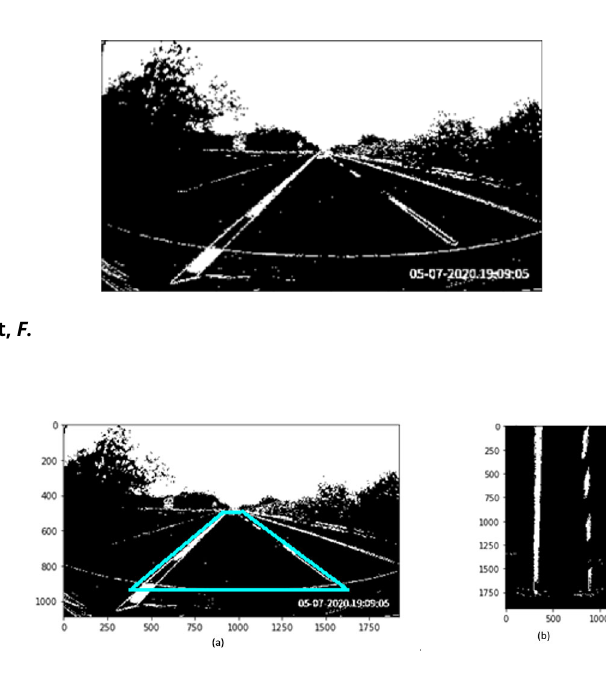
Figure 4. Perspective transformation, (a) Source image in oblique view, (b) Warped result into birds-eye view.